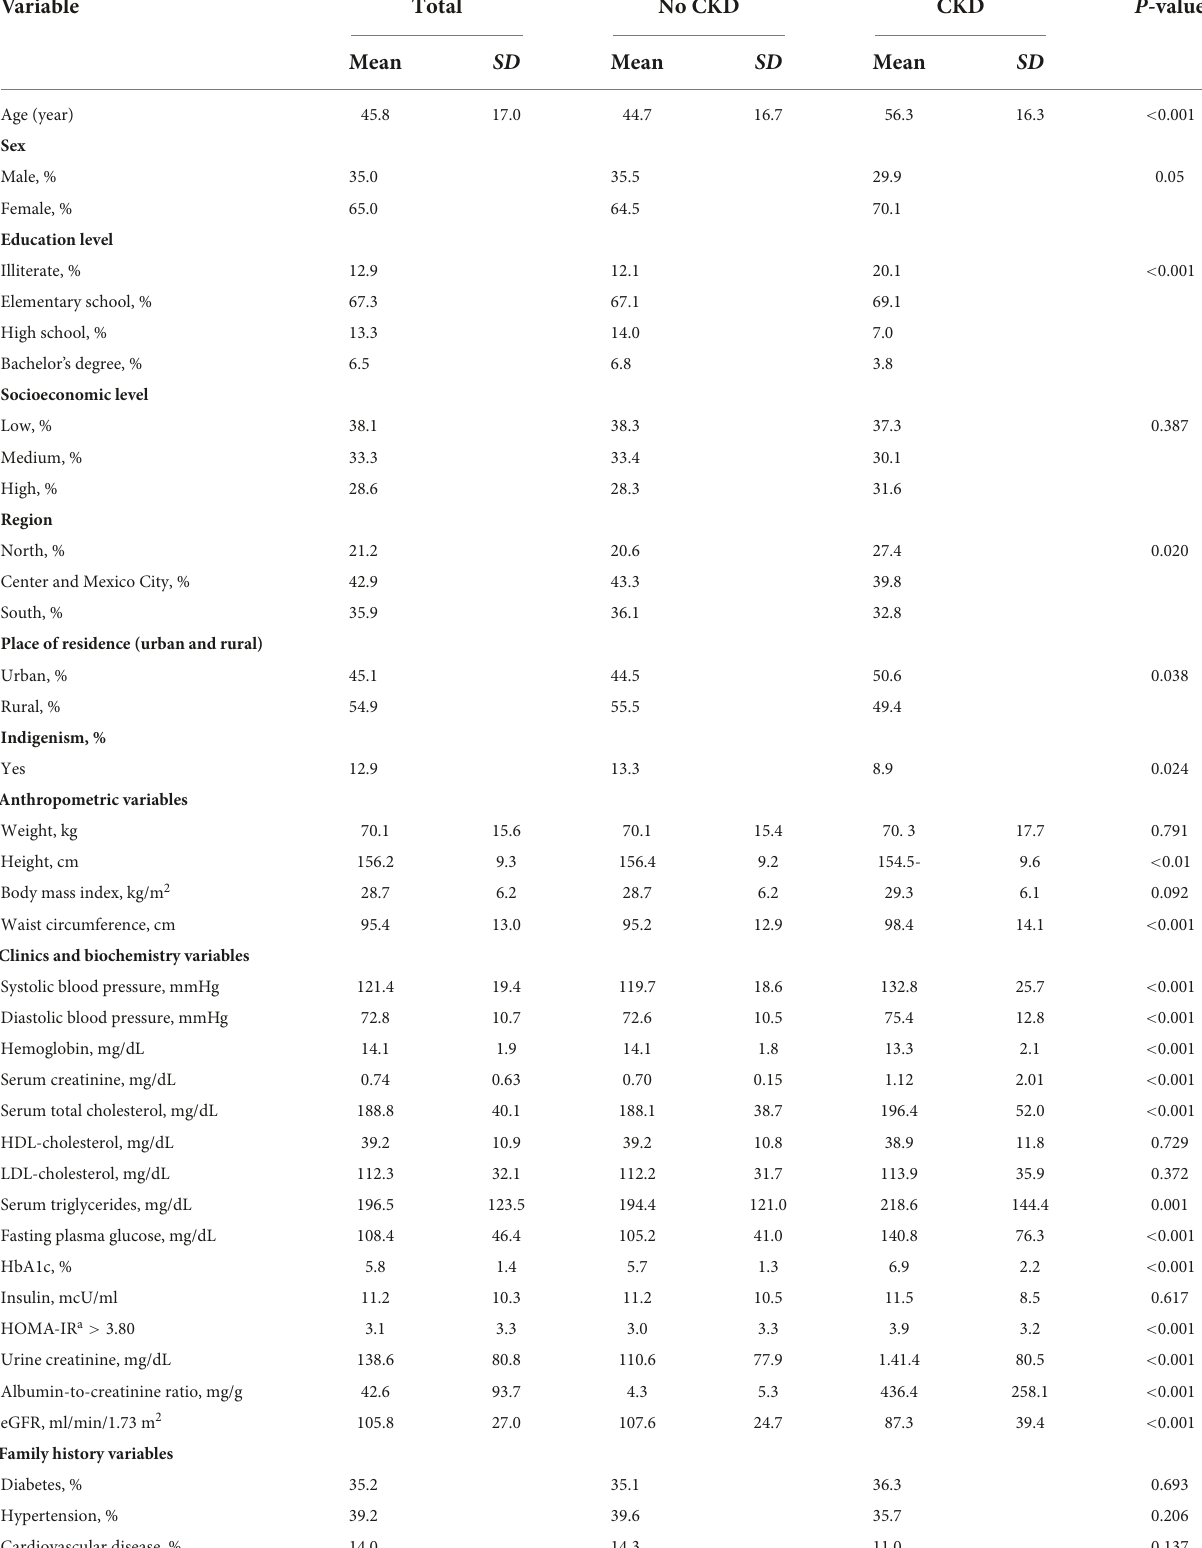
TABLE 1 Main characteristics of Mexican National Health and Nutrition Survey 2016, according to the presence of chronic kidney disease.